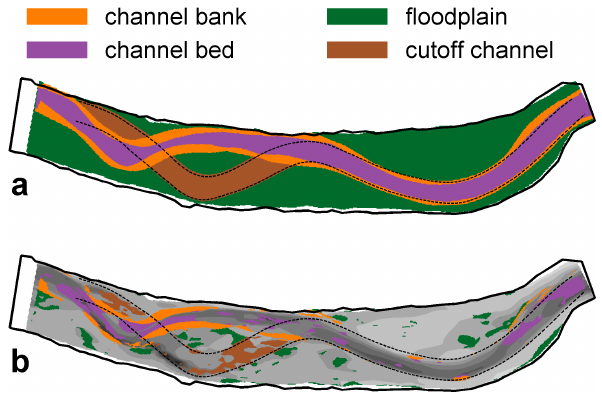
Figure 2. Segregation of geomorphic zones between surveys 4 and 5. (a) Masks of each of the four geomorphic zones, including chan- nel bank (orange), channel bed (purple), floodplain (green) and cut- off channel (brown). (b) Resulting